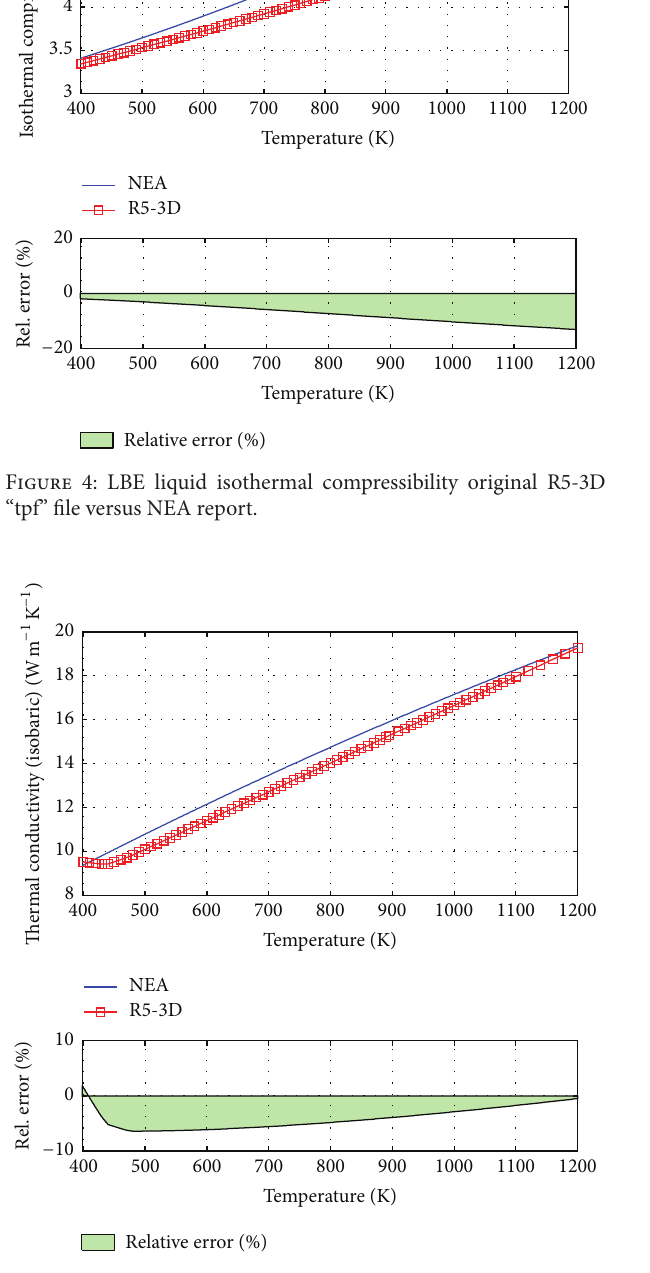
Figure 5: LBE liquid thermal conductivity original R5-3D “tpf” file versus NEA report.